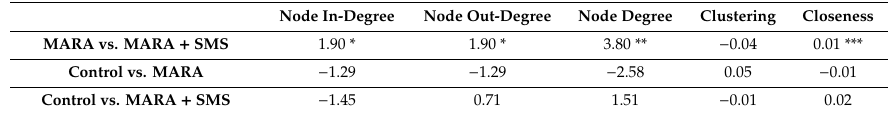
Table A5. Comparison between MARA vs. MARA + SMS di ff erence in di ff erence. The table shows the estimates value of each di ff erence in di ff erence model and its